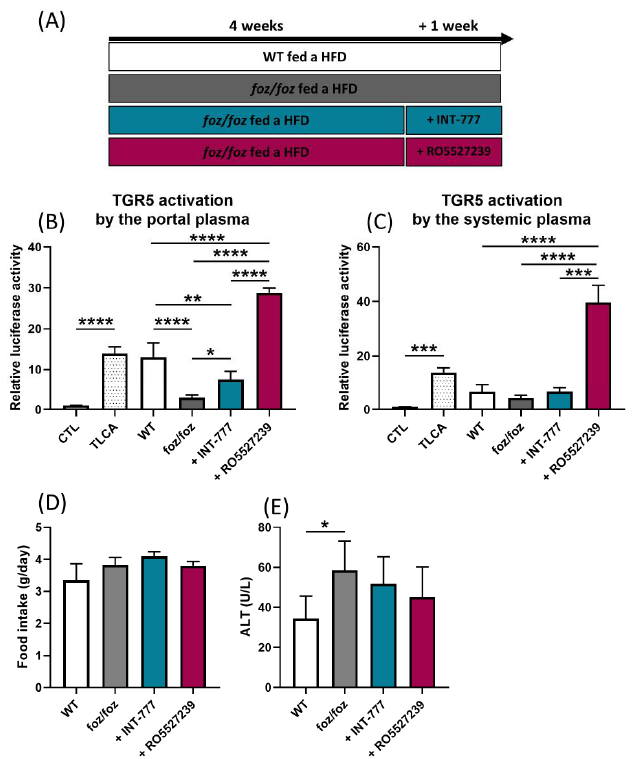
Figure 3. INT-777 and RO5527239 are well tolerated and reactivate TGR5. ( A ) After 4 weeks of HFD, foz/foz mice received an HFD containing INT-777, an HFD containing RO5527239 or a plain HFD for one additional week. HFD-fed WT mice were used as controls. ( B , C ) TGR5 activation by the portal or systemic plasma of WT, foz/foz , foz/foz + INT-777 or foz/foz + RO5527239 mice (n = 5–7/group) in the cell reporter assay. CTL represents the basal activation and TLCA the activation induced by tauro-lithocholic acid, which was used as a positive control. ( D ) Mean food intake. ( E ) ALT levels in systemic plasma of WT, foz/foz , foz/foz + INT-777 or foz/foz + RO5527239 mice. Mean ± SD. One- way ANOVA followed by post hoc Bonferroni correction. Statistical significance is represented by * p < 0.05; ** p < 0.01; *** p < 0.001 and **** p < 0.0001. All p -values < 0.05 are represented on the graphs, while p -values > 0.05 are not. Of note, the daily food intake was similar among the groups, indicating that the pres- ence of either compound did not preclude HFD consumption (Figure 3D, p > 0.2971). The body weight of foz/foz mice was unchanged by the treatments (data not shown). The plas- matic concentrations of alanine aminotransferases (ALT), reflecting hepatocyte damage